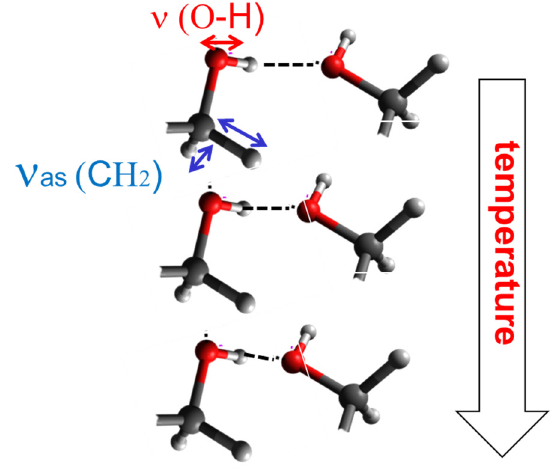
Figure 8. Scheme interpreting the observed specific orientation polarization for the O-H and CH 2 moieties. The former has a dipole moment of 2.67 Debye; at temperatures > 283 K the O-H . . . O bonds are open, and the O-H dipole is subject to orientation polarization. With decreasing temperature, H-bonds are formed counteracting orientation fluctuations. The CH 2 unit is nearly nonpolar, but due to the immediate neighborhood of the polar O-H moiety, it is coupled to its orientation fluctuations. With increasing H-bond, formation dies out as well.